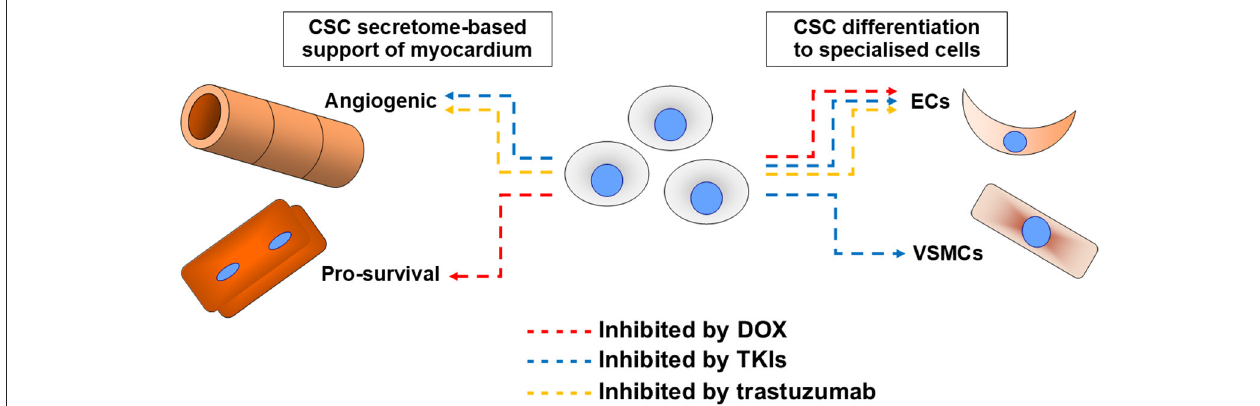
FIGURE 1 | Summary of cardiotoxin effects on cardiac stem cell (CSC) abilities. Impacts of the most examined cardiotoxin doxorubicin (DOX, red), tyrosine kinase inhibitors (TKIs, blue), and trastuzumab (orange) on CSC abilities to support myocardium via secretome support of angiogenesis or cell survival (most critically cardiomyocyte survival), or via their differentiation into endothelial cells (ECs) or vascular smooth muscle cells